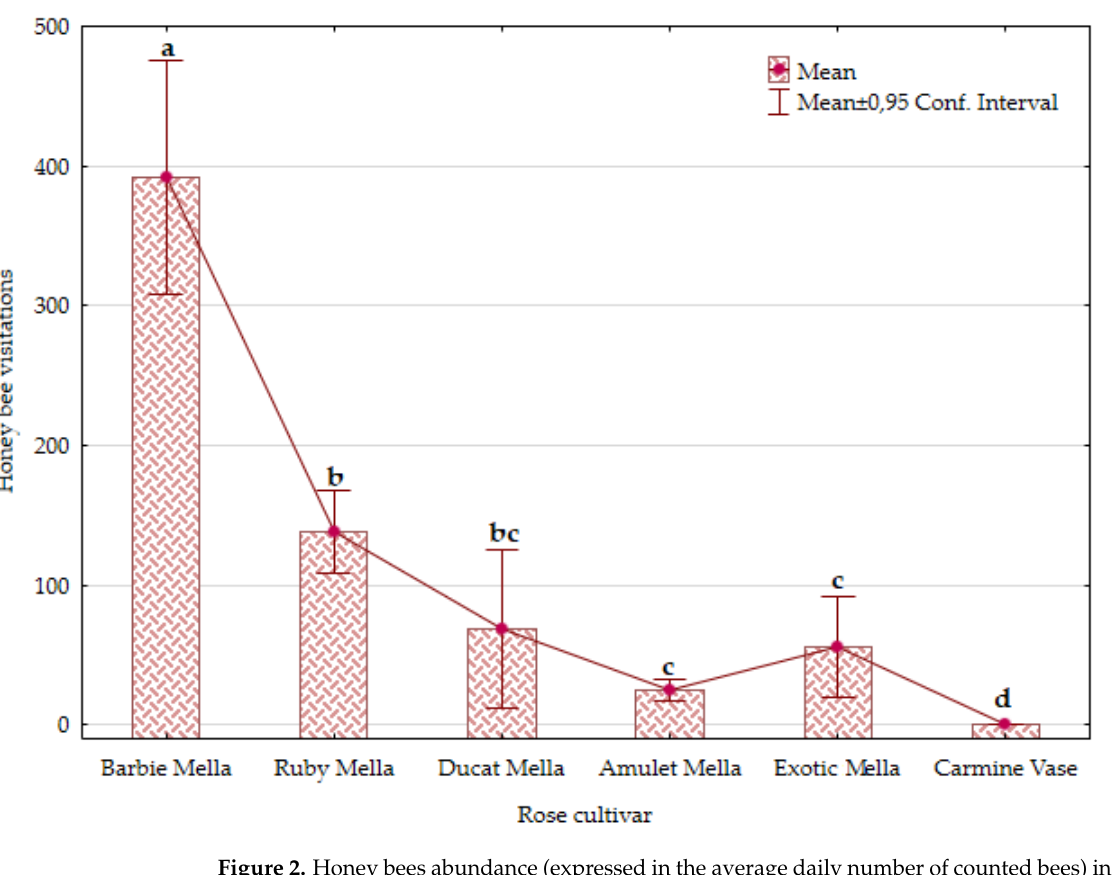
Figure 2. Honey bees abundance (expressed in the average daily number of counted bees) in different ‘Mella’ rose cultivars. Mean values designated with the same letter were not significantly different according to Tukey’s Honest Significant Difference test ( p ≤ 0.05).